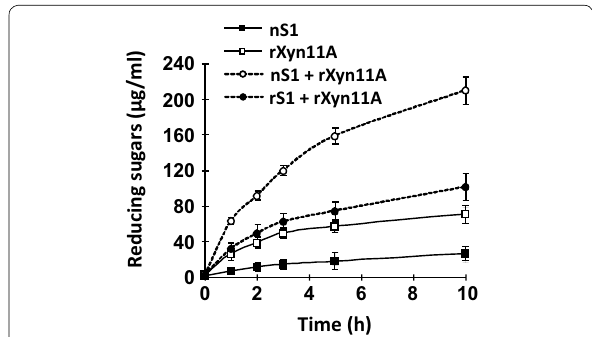
Fig. 5 Hydrolysis activity profiles. The enzymatic activities of nS1, rXyn11A, the nS1 plus rXyn11A complex, and the rS1 plus rXyn11A complex toward birchwood xylan were independently determined by measuring the amount of reducing sugar released from 0.5% substrate at 60 °C. The complexes were assembled by mixing nS1 or rS1 with rXyn11A at fixed concentrations (0.5 μM). Data are presented as the means from three independent experiments. Error bars represent the standard deviations (n =